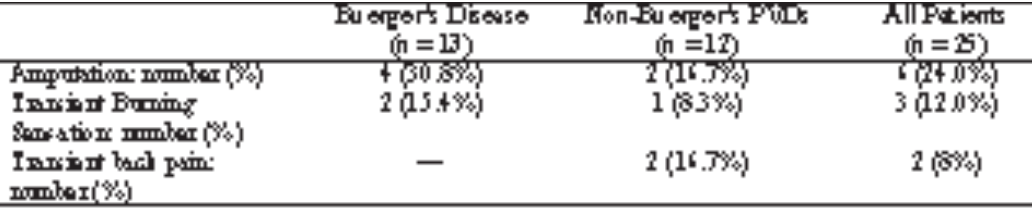
Table IV : Need for amputation and complications at 3